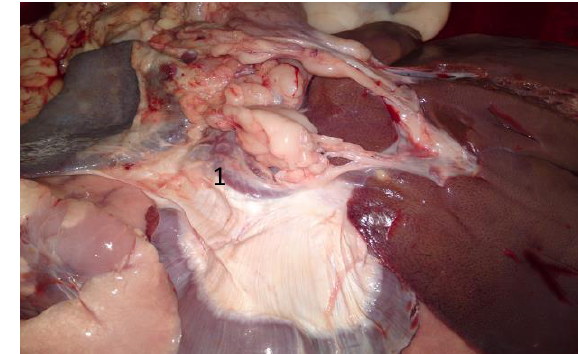
Interlobular (3) in goat.